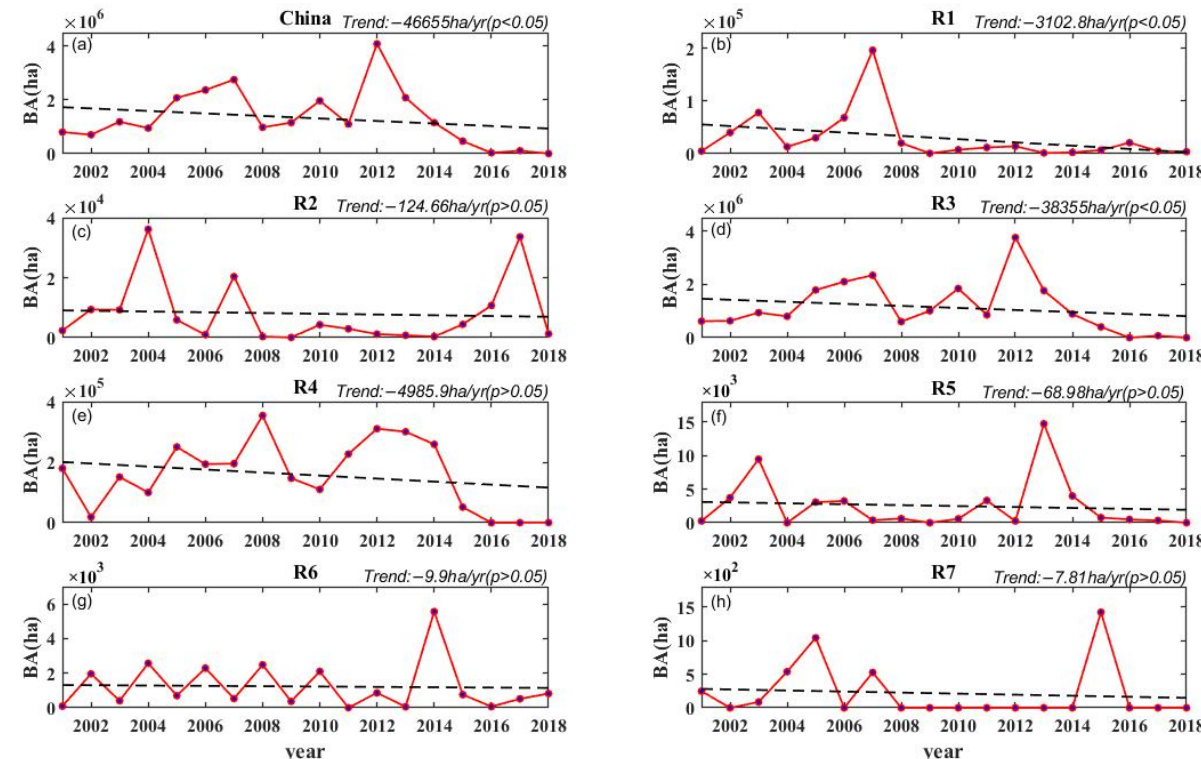
Figure 6. The trends of the BA in China and R1–R7 in summer.